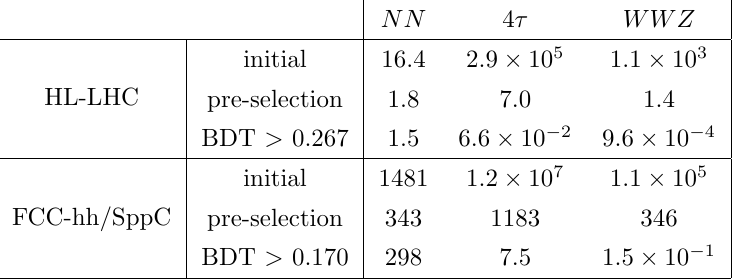
Table 1 . Event rates for the signal from h 1 NN e (cid:6) e (cid:6) (cid:22) (cid:7) (cid:22) (cid:7) 2 (cid:23) with m N = 20 GeV and ! ! BF h = 10 (cid:0) 7 and for background processes of 4 (cid:28) and WWZ . The numbers at the 1 ! e (cid:6) e (cid:6) (cid:22) (cid:7) (cid:22) (cid:7) 2 (cid:23) HL-LHC (FCC-hh/SppC) correspond to center-of-mass energy p s = 14(100) TeV and 3 (20) ab (cid:0) 1 integrated